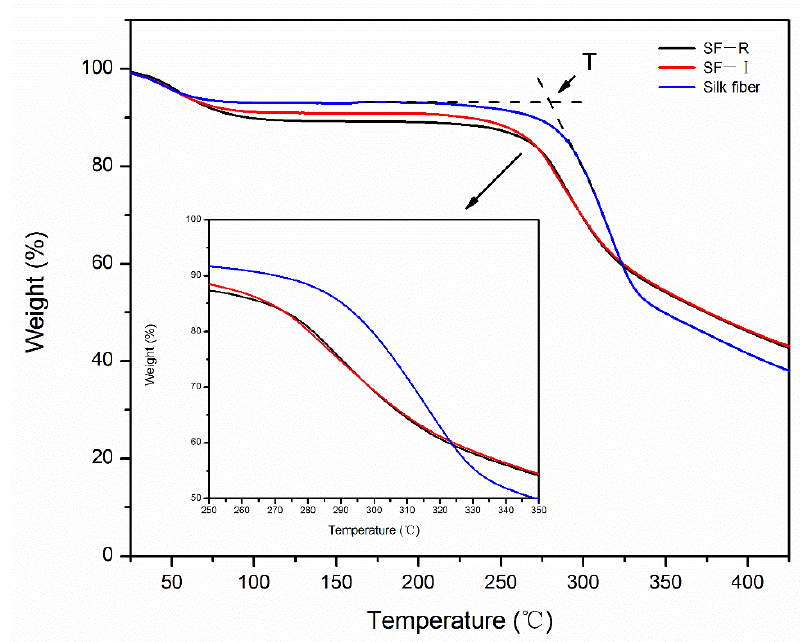
Figure 7. Thermogravimetric analysis (TGA) curves of different silk fibroin materials (SF-I, SF-R, and silk fibers).